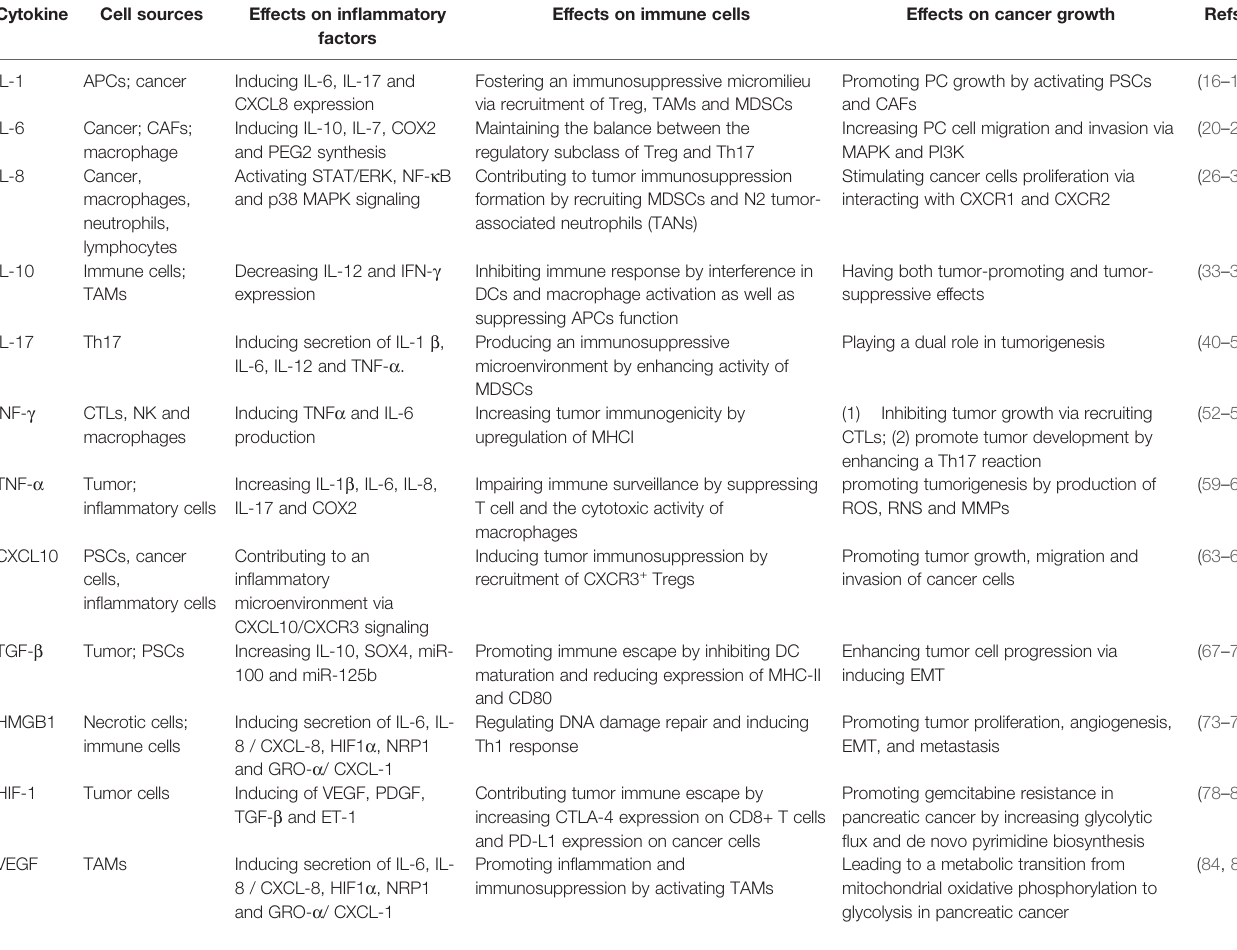
TABLE 1 | The cytokine network in the in fl ammatory immunosuppressive microenvironment of pancreatic